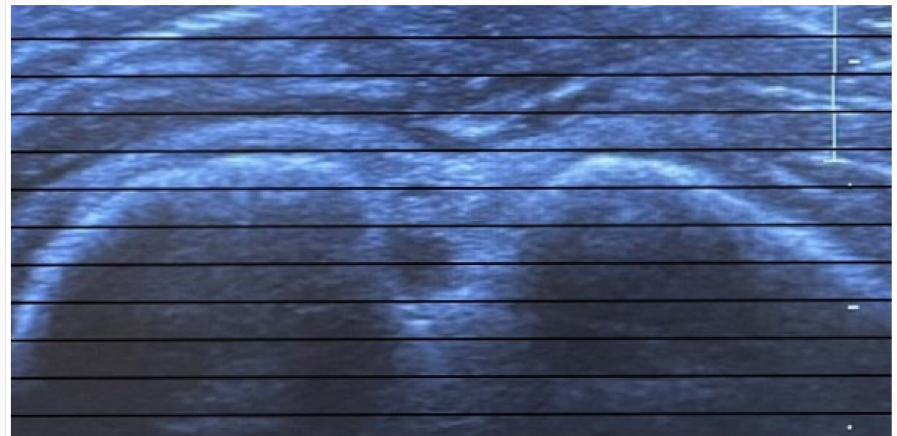
Figure 3. Greater and lesser tuberosities are displayed horizontally in one plane with the aid of a film with horizontal parallel lines attached to the screen of the ultrasound